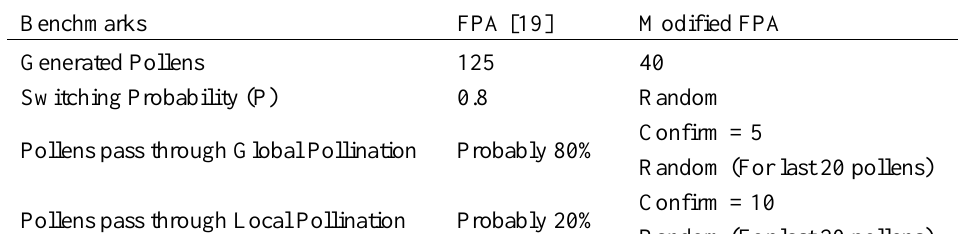
Logical comparison of FPA and the proposed MFPA algorithms